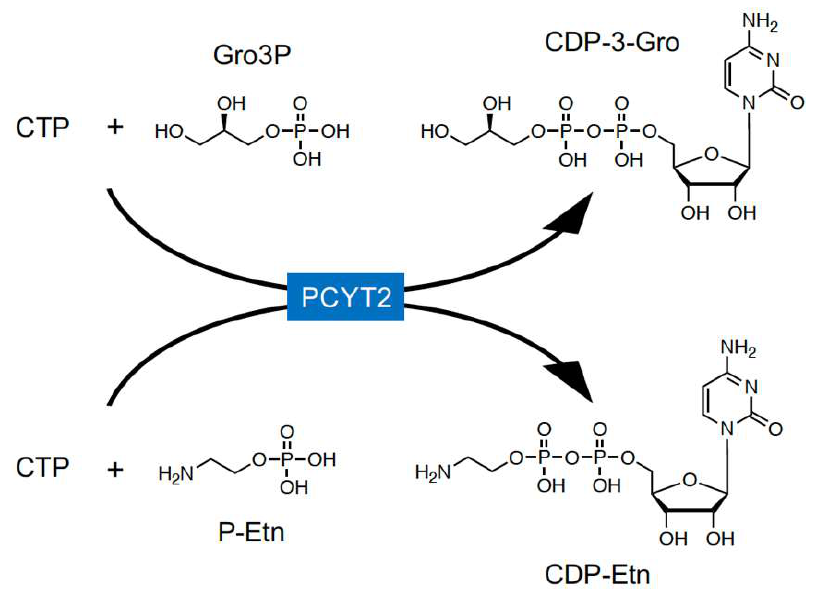
Figure 3. In mammals, PCYT2 catalyzes the synthesis of CDP-Etn from CTP and P-Etn, and PCYT2 also synthesizes CDP-3-Gro from CTP and Gro3P.